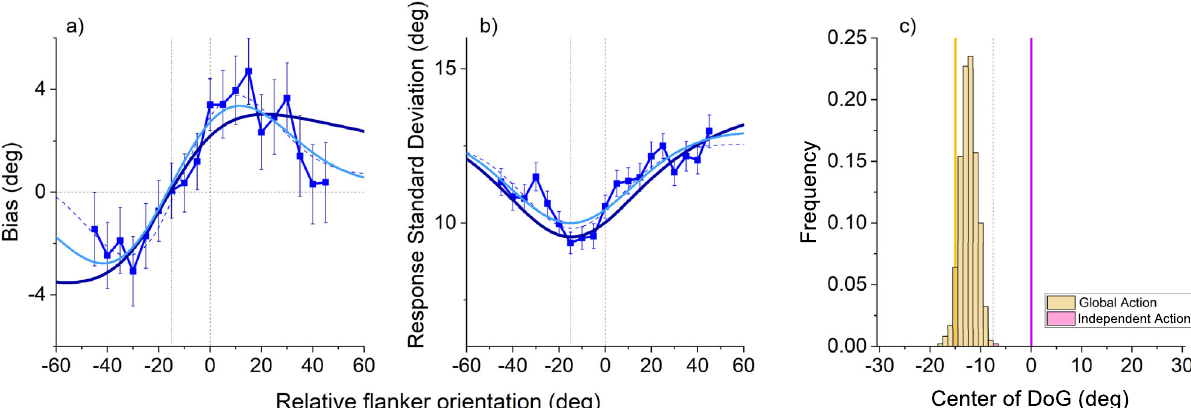
Fig.5|Integrationdependsonorientationofboth fl ankers,indicatingaglobal siteofaction.a Biasingerrorsasfunctionofasingle fl ankerorientation,whilethe other fl anker was locked at +15°. Error bars show ±1 SEM. Colours and conven- tions as for Fig. 2. N =13 observers. Thick dark lines refer to the ideal observer model (Eq. 10), thick light blue lines to the causal inference model (Eq. 15).